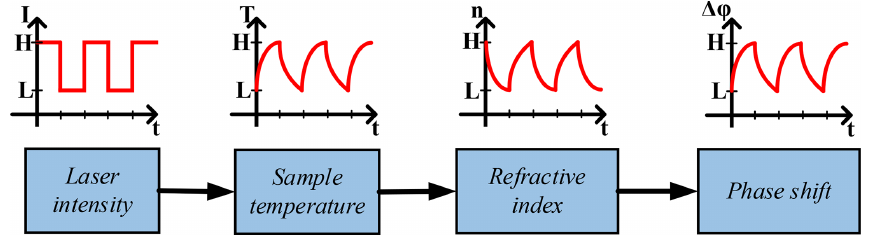
Figure 1. Scheme of PTI signal generation and measurement. For standard pump–probe PTI measurements, the laser power at the low level is L =